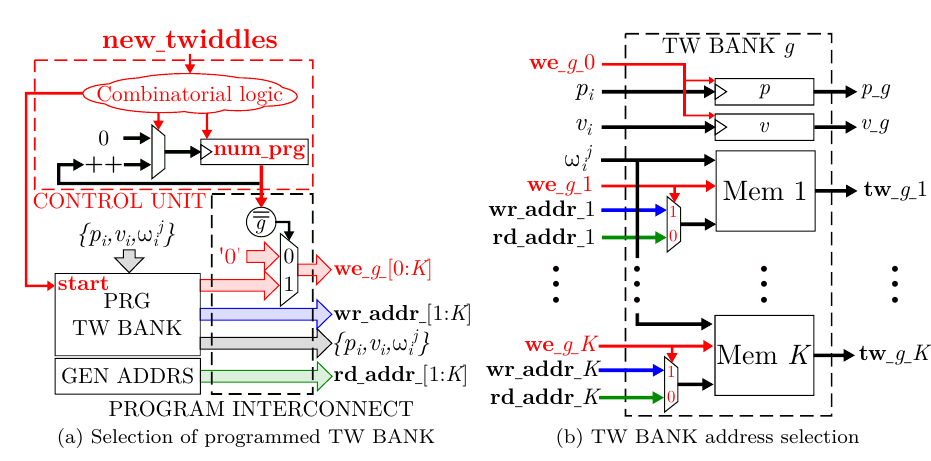
Figure 3: Bank of memory reprogramming. Schematics for w =